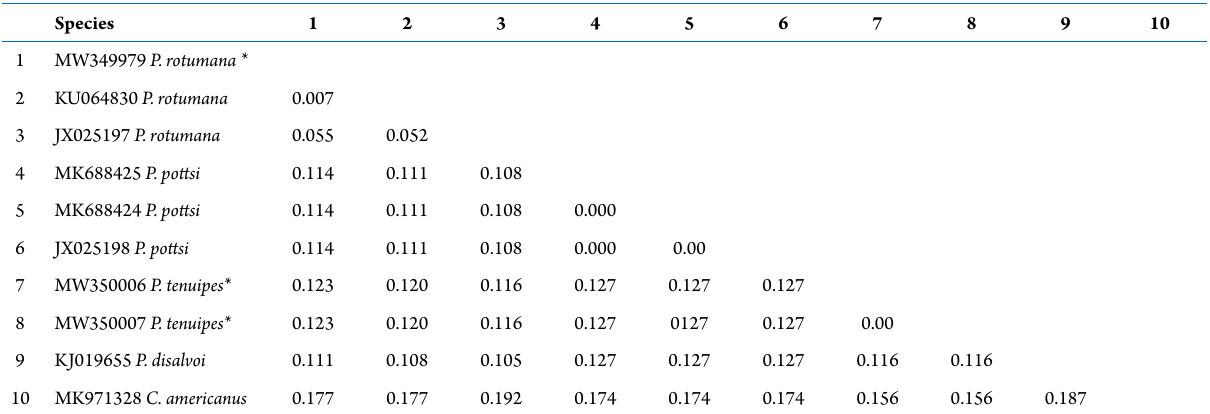
Table 3. Pairwise genetic analysis conducted using available 16S gene sequences in GenBank with the present Indian materials of the genera Palaemonella and Cuapetes .